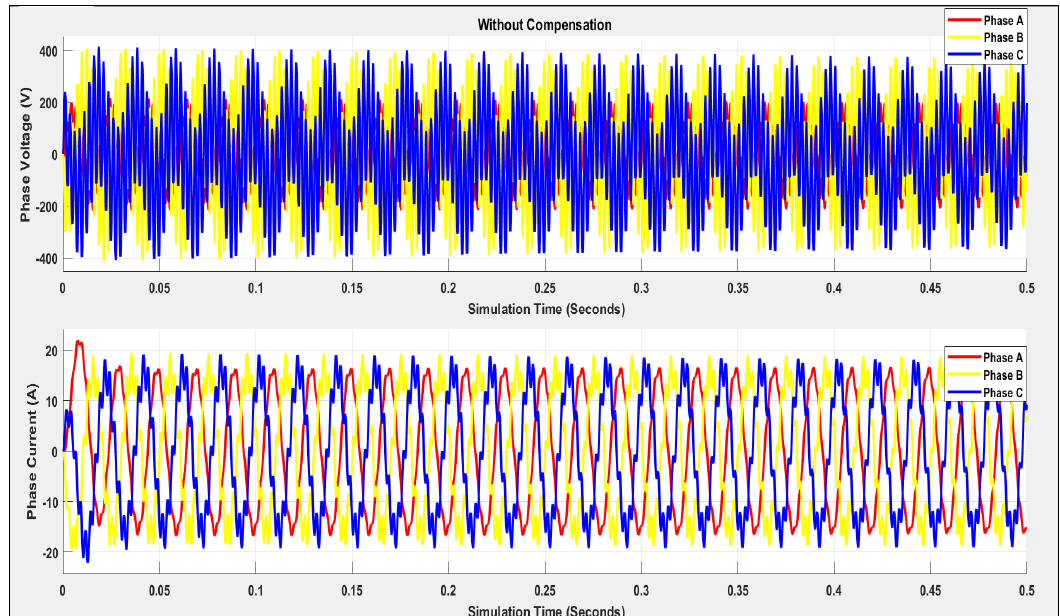
Figure 13. The THD performance results without compensation.